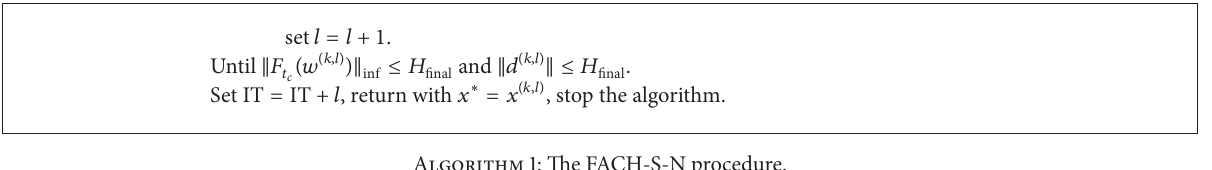
Algorithm 1: The FACH-S-N procedure.